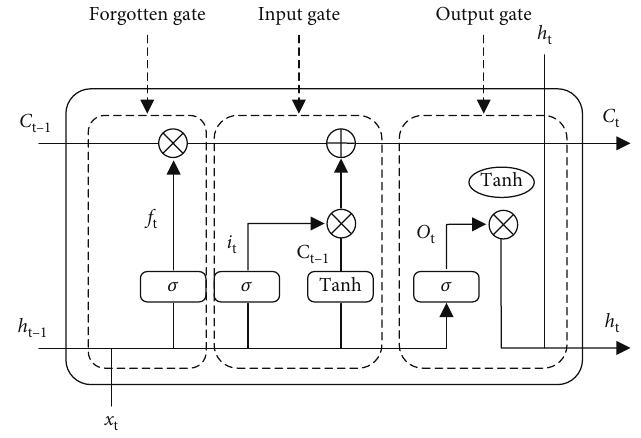
Figure 2: Door structure of LSTM unit.